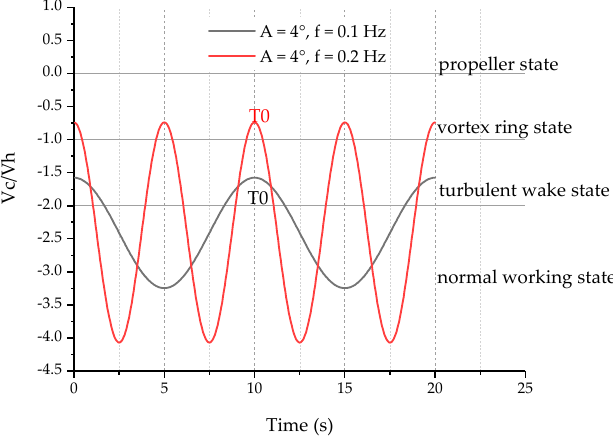
Figure 6. VRS identification scheme under pitch motion.